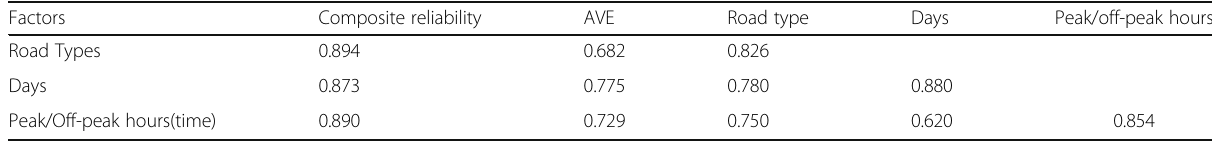
Table 7 Discriminant and Convergent Validity (Square root of AVE on the diagonal cells) Factors